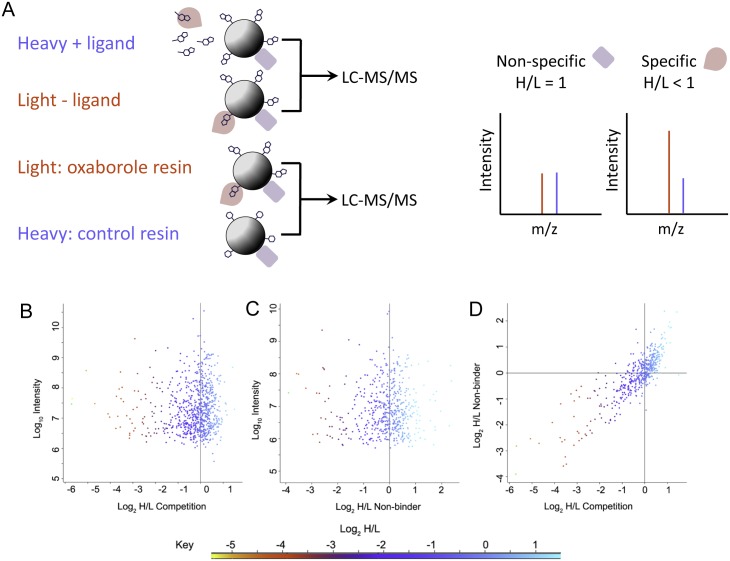
Quantitative chemical proteomic profiling of oxaborole targets.
A–Schematic of proteomic profiling strategies representing ligand competition experiment (top) and resin comparison experiment (bottom). B–Drug competition experiment. SILAC-labelled T. brucei cell lysates were incubated with 10 μM Oxaborole-1 (heavy label) or DMSO control (light label), prior to enrichment of protein with Oxaborole-Resin. C–Comparison of analogue-bound resin. Proteins were enriched from SILAC labelled T. brucei cell by Oxaborole-Resin (light label) or Control-Resin (heavy label). D–Correlation of the proteins quantified by the two strategies. A colour key is included to show the range of enrichment of identified proteins.